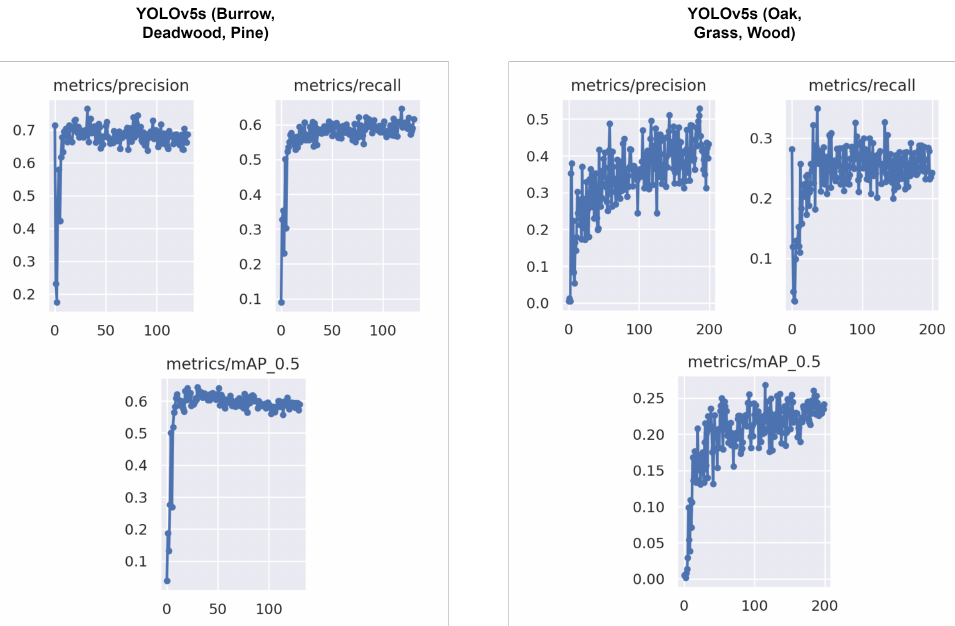
Figure 14. The result graphs of YOLOvs on FHI